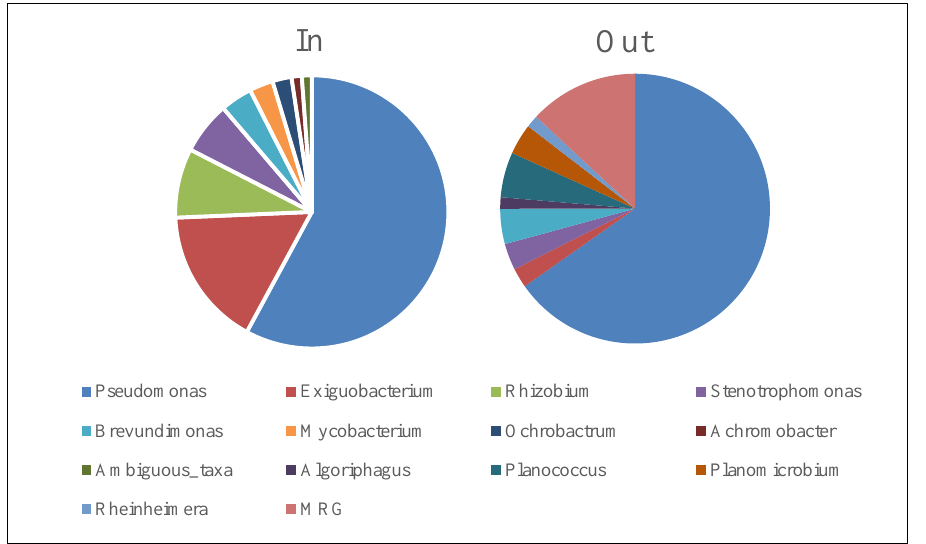
Figure 4. Taxonomic information (genus level) based on 16S rRNA gene sequences of the indigenous bacteria during Site B's